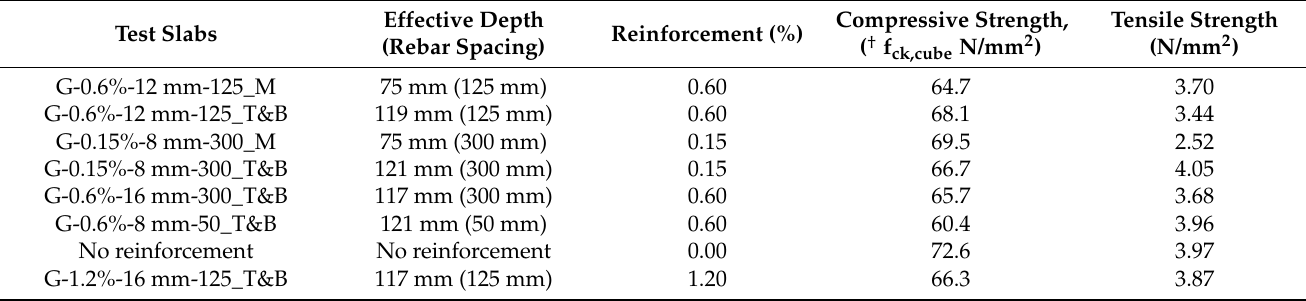
Table 1. Details of the test slabs and test